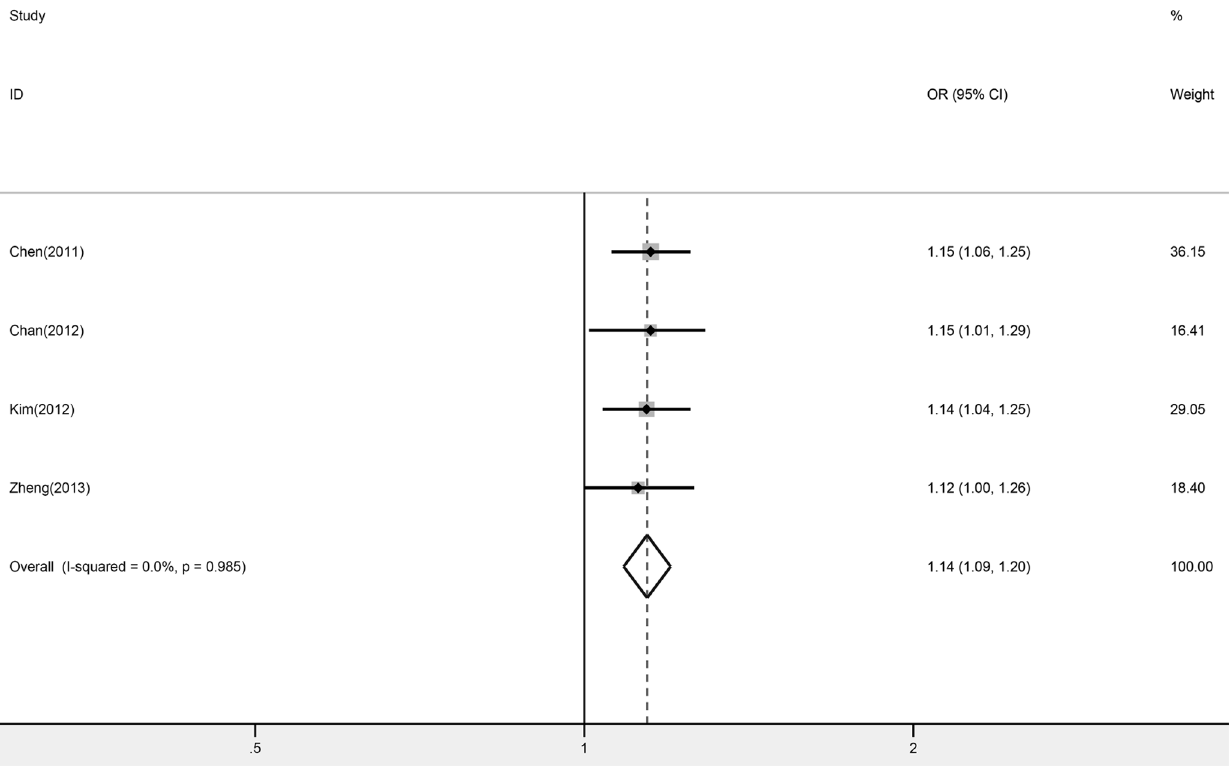
Figure 3. Forest plot of MAP3K1 rs16886165 polymorphism and breast cancer risk. Fixed-effect model was used for the analysis (allele contrast model G vs. T).